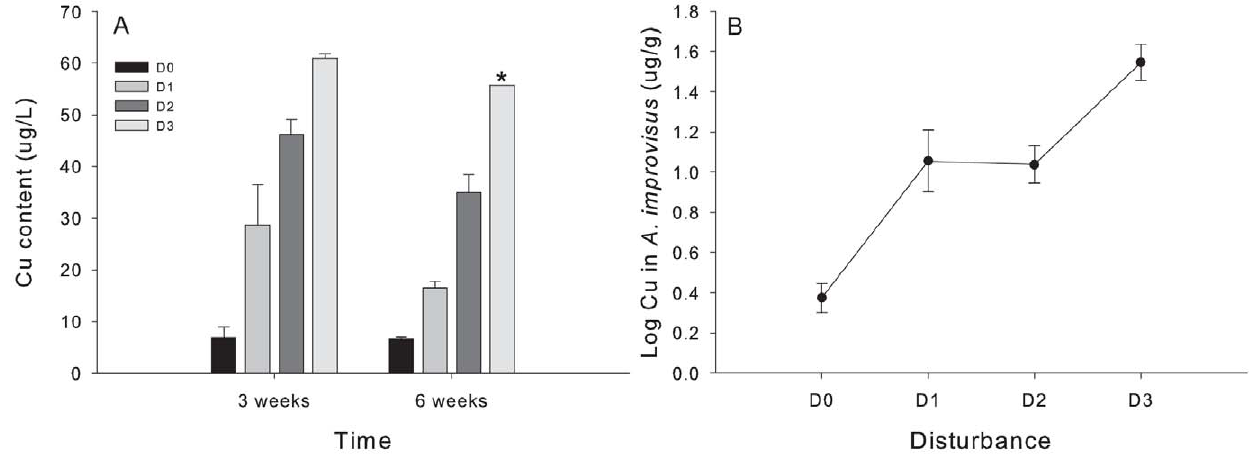
Figure 2. Test for treatment’s efficiency. (A) Copper content from water samples after a 2 hr exposure to disturbance panels taken after 3 and 6 weeks in Virginia from independent buckets containing individual disturbance treatments (n=2); (B) Quantity of copper measured after 9 weeks from the tissue of Amphibalanus improvisus , the most common organism across all disturbance treatments in Virginia (n=4). Means and standard deviations are indicated. Disturbance treatments abbreviations are as in Figure 1. * There is no standard deviation at D3 after 6 weeks as there was only one replicate.